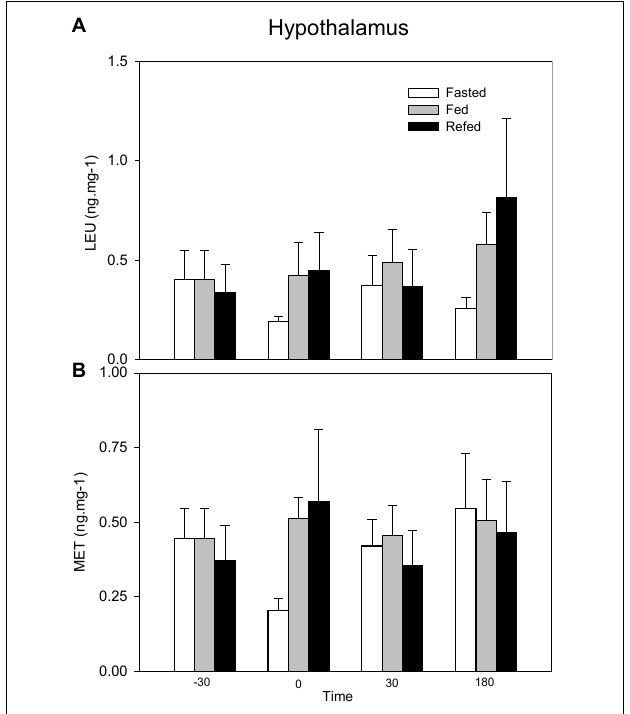
FIGURE 3 | Levels of Leu-enkephalin (LEU, A ) and Met-enkephalin (MET, B ) in hypothalamus of fasted, fed an refed rainbow trout sampled at different periprandial times (-30, 0, 30, 180 min). Each value is the mean + S.E.M. of 10 fish.